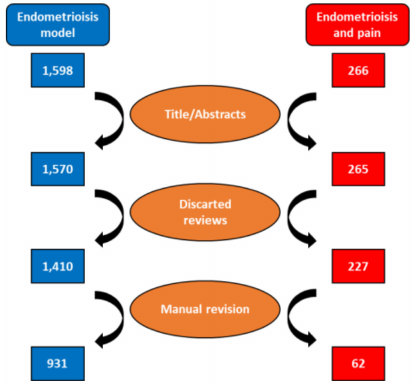
Figure 1. Flowchart of manuscript selection. The left column represents the total number of articles that studied endometriosis in rodents, while the right column shows the total number of articles that studied pain in rodent models of endometriosis.